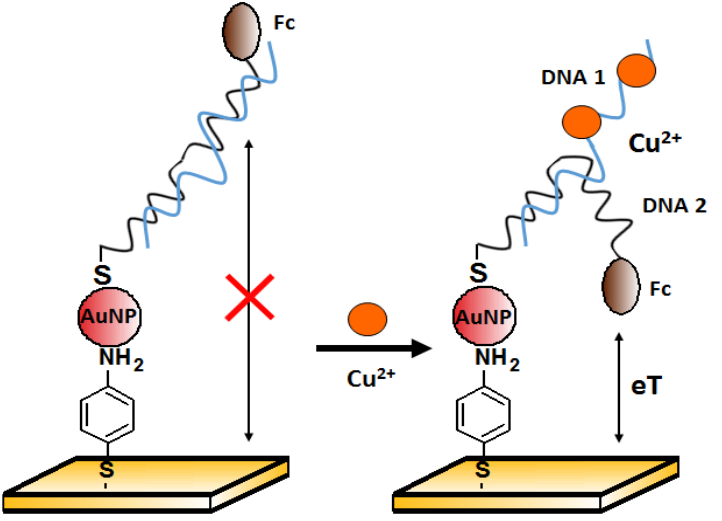
Figure 19. Scheme of the electrochemical sensor with AuNPs for Cu 2+ ion detection.